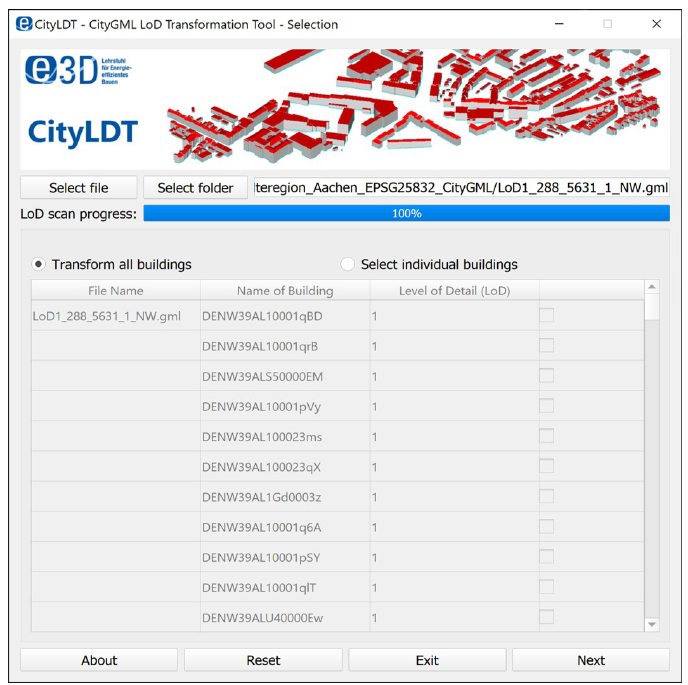
Figure 4. Overview of the main window of